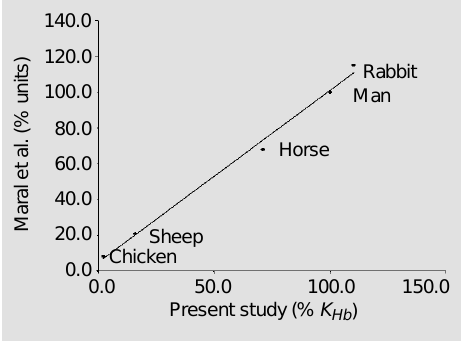
Figure 6 - Relative erythrocyte catalase activity for different species. The figure shows the Rabbit similarity between the data of Man Maral et al. (21) and those of the present study. In each series the Horse value for human erythrocytes was taken as 100%. The equa- tion of the straight line is y = 0.9622x + 4.9034. R 2 = Sheep Chicken